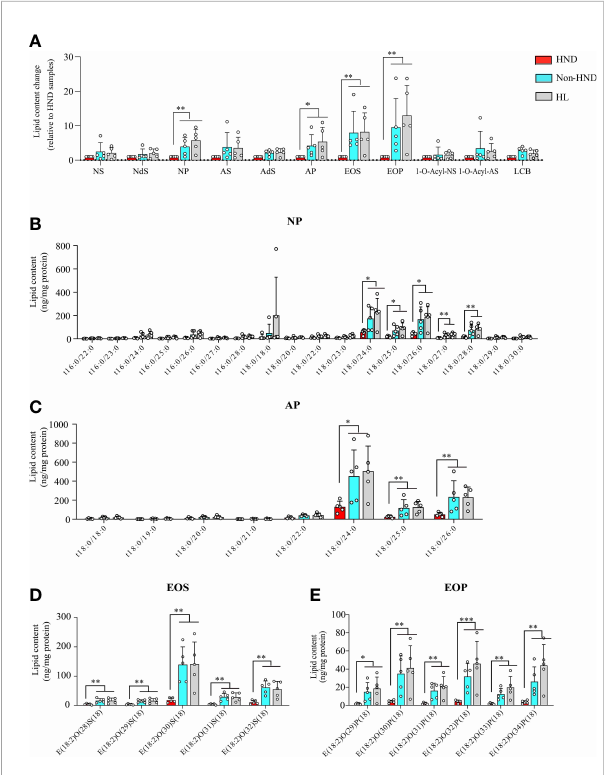
FIGURE 5 Decreased ceramide in AD patients with HND. (A) Overall differences in the amounts of various ceramide types according to the presence of HND. Individual ceramide components belonging to ceramide types, which were signi fi cantly reduced in HND patients; (B) NP, (C) AP (D) EOS, (E) EOP. ( fi ve replicates for each column,